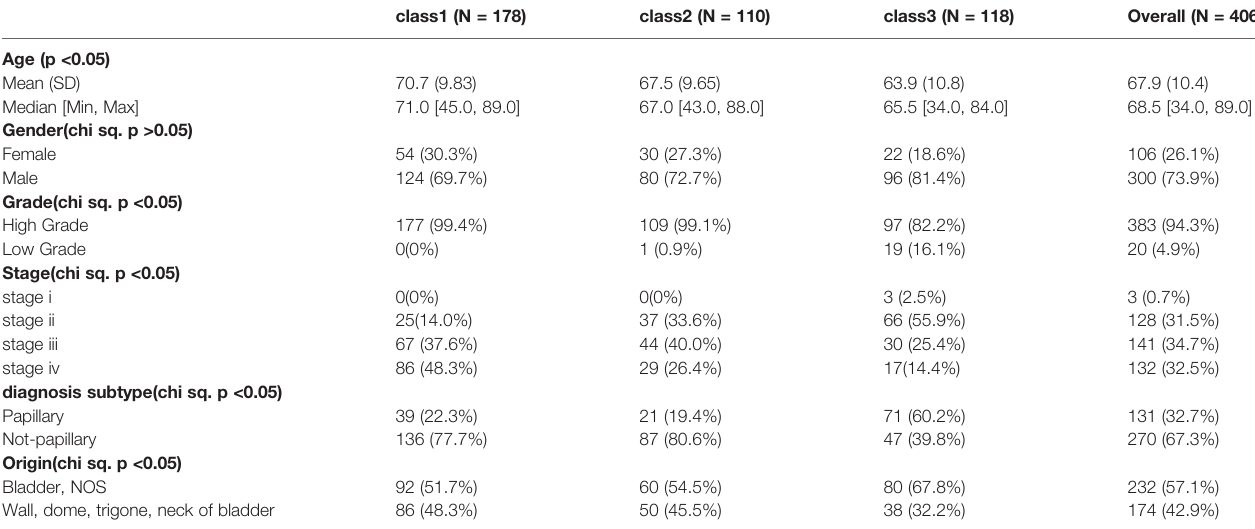
TABLE 1 | Clinical Information of